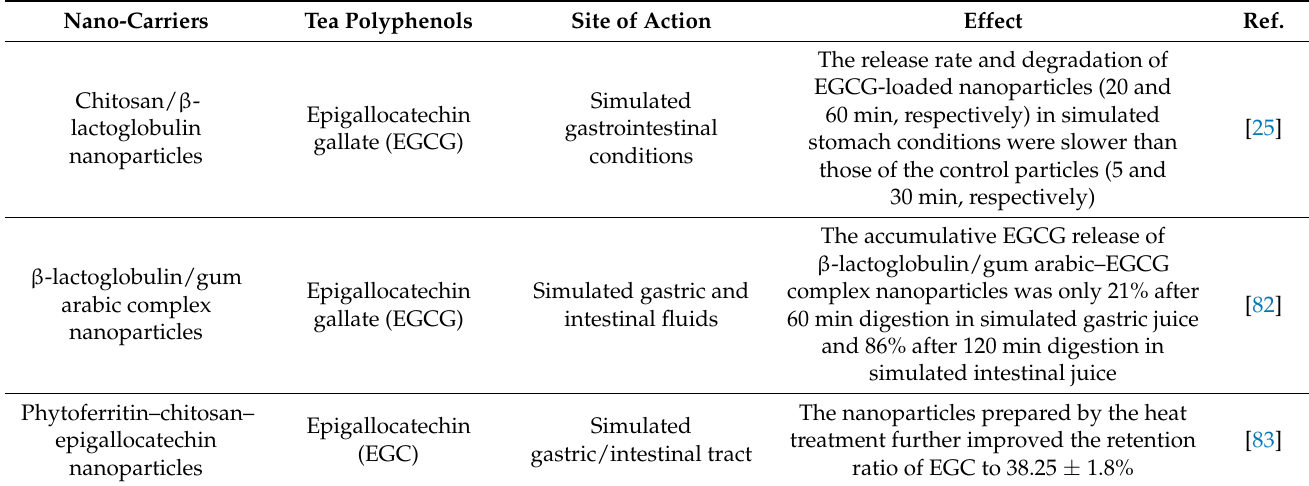
Table 1. Applications of TPs nanostrategies in functional ingredient delivery.